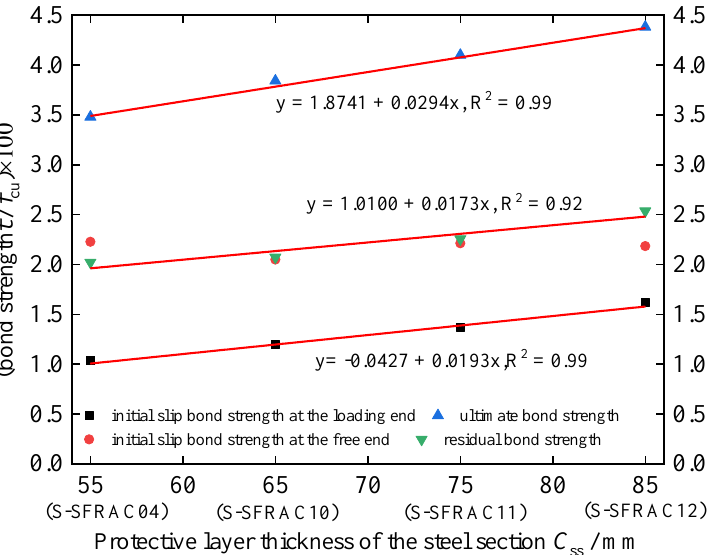
Figure 18. Relationship between the bond strength and thickness of the section steel protection layer.